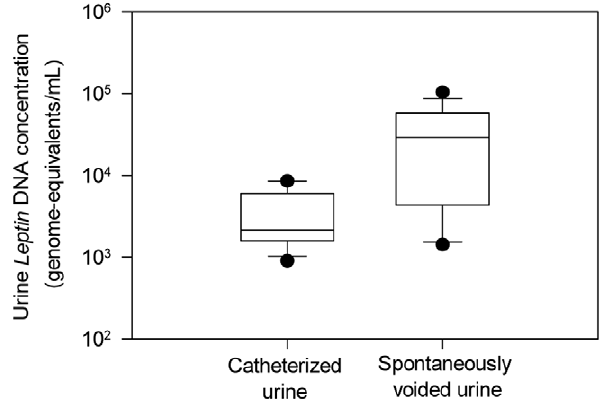
Figure 1. LEP DNA concentrations in the catheterized and spontaneously voided maternal urine samples. The lines inside the boxes denote the medians. The boxes mark the interval between the 25 th and 75 th percentiles. The whiskers denote the interval between the 10 th and 90 th percentiles. The circles mark the data points outside the 10 th and 90 th